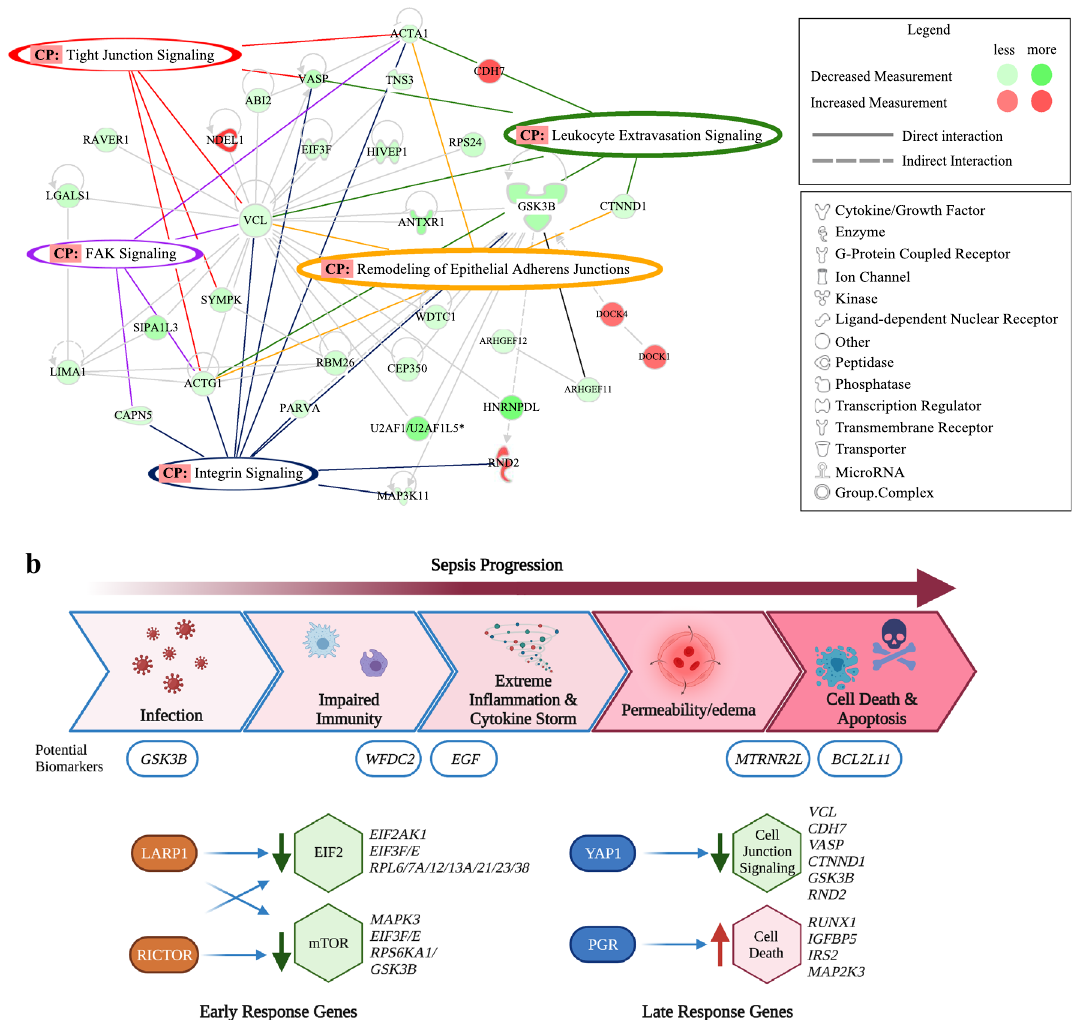
Figure 4. Differentially expressed genes between Native Hawaiians and Japanese reveal Late Response Sepsis (LRS) genes involved in cell–cell junction regulation and barrier permeability. ( a ) Differentially expressed network indicating the connections and interacting partners of permeability-regulating junction canonical pathways (tight junction signaling, leukocyte extravasation signaling, remodeling of epithelial adherens junctions, FAK signaling, and integrin signaling). ( b ) Schematic of sepsis progression steps with listed potential biomarkers and associated ERS and LRS genes grouped by their predicted upstream regulators and affected